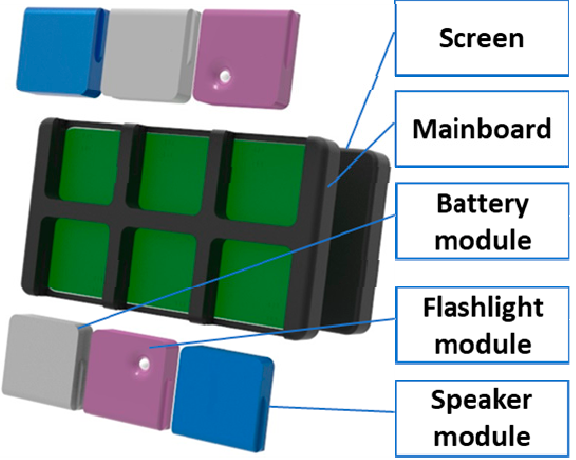
Figure 9. Customizable tablet example.